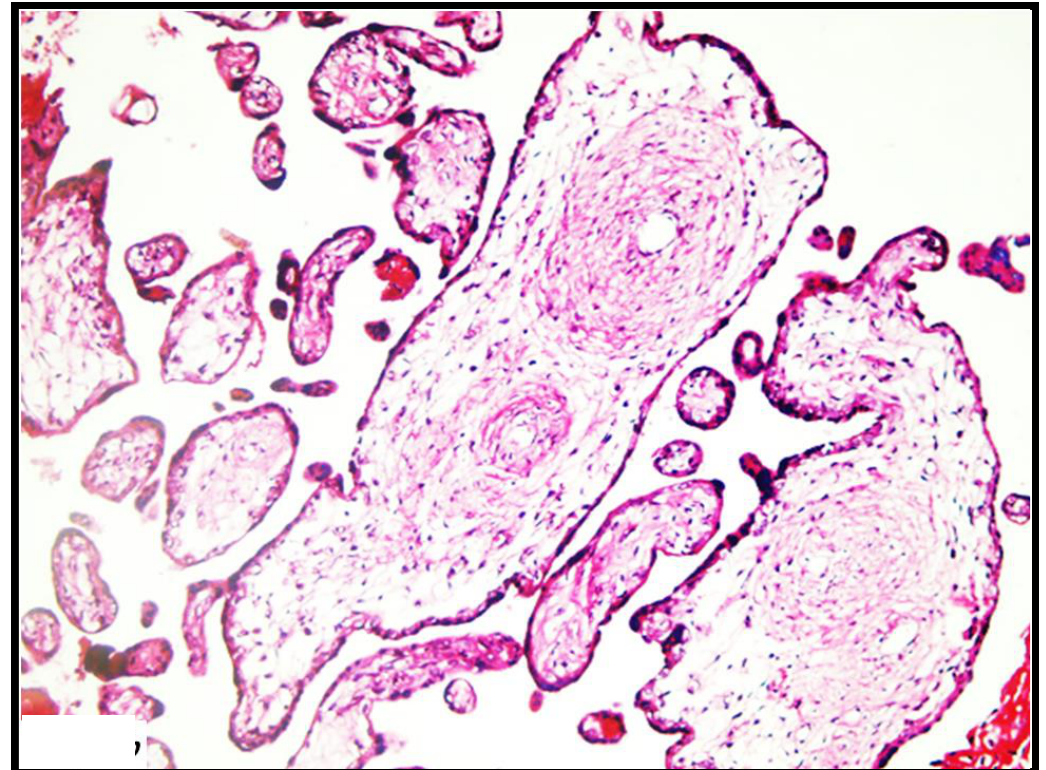
Figure 2: Chorionic blood vessels with hyperplastic muscular walls (X 200)